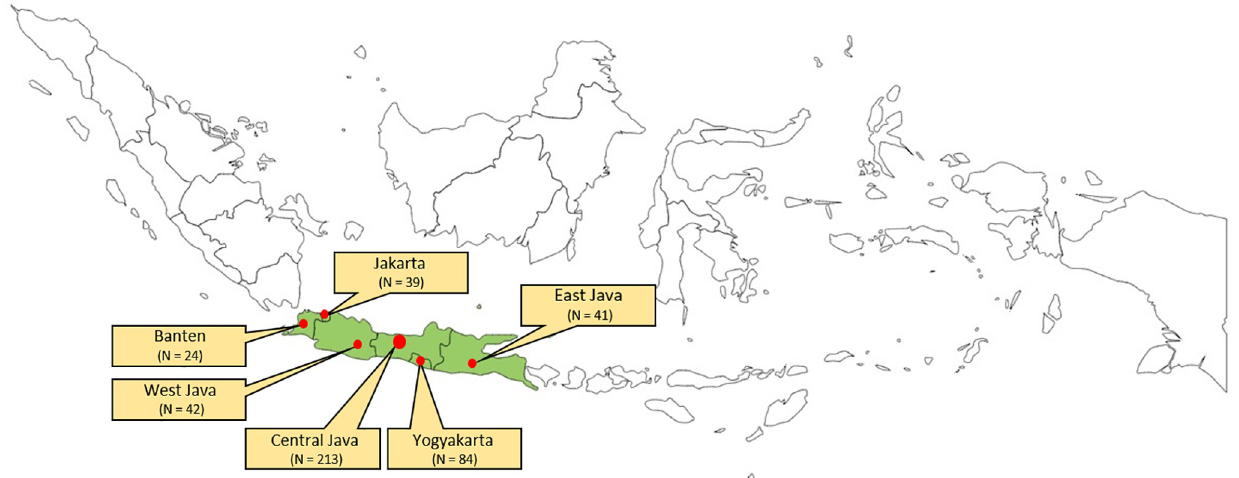
Fig 2. The distribution of respondents who completed the questionnaire survey from the six provinces on Java Island.